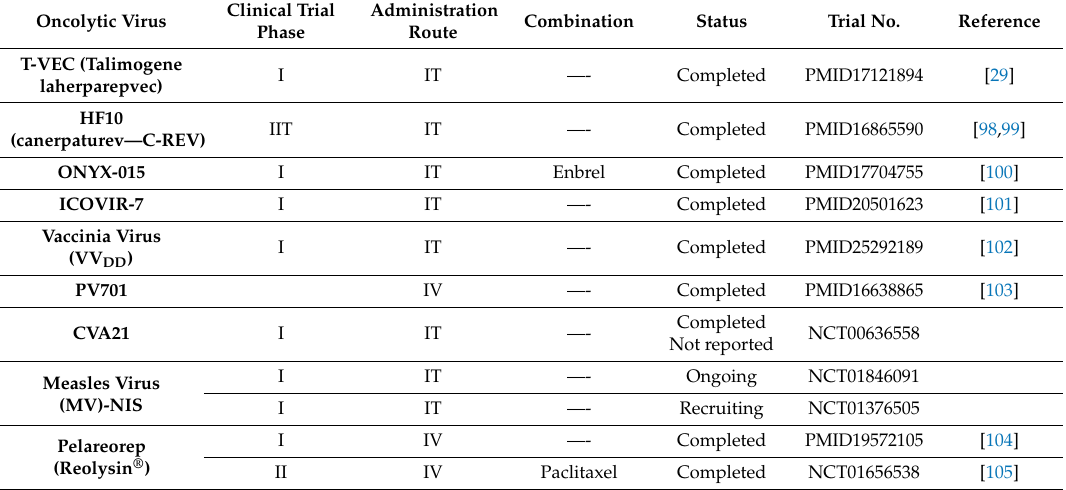
Table 5. The clinical trials of oncolytic viruses in patients with breast cancer. Oncolytic